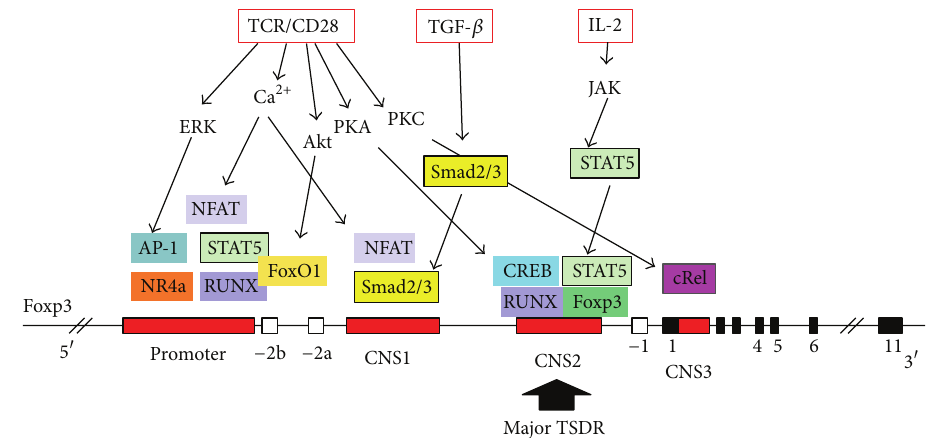
Figure 1: Transcription factors and signals that are involved in Foxp3 induction and stable expression. The promoter and CNSs (conserved noncodingsequences)intheintronsareshown.InthecourseofTregcelldevelopment,epigeneticchangestakeplaceandaccessibilityofCNS2 increases by DNA demethylation, histone modifications, and possibly nucleosome repositioning. The CNS2 region serves as an enhancer for Foxp3 transcription and is bound by transcription factors such as Foxp3, STAT5, and CREB. These epigenetic alterations are maintained irrespective of environmental changes and thus allow stable Foxp3 transcription by constitutively expressed transcription factors.